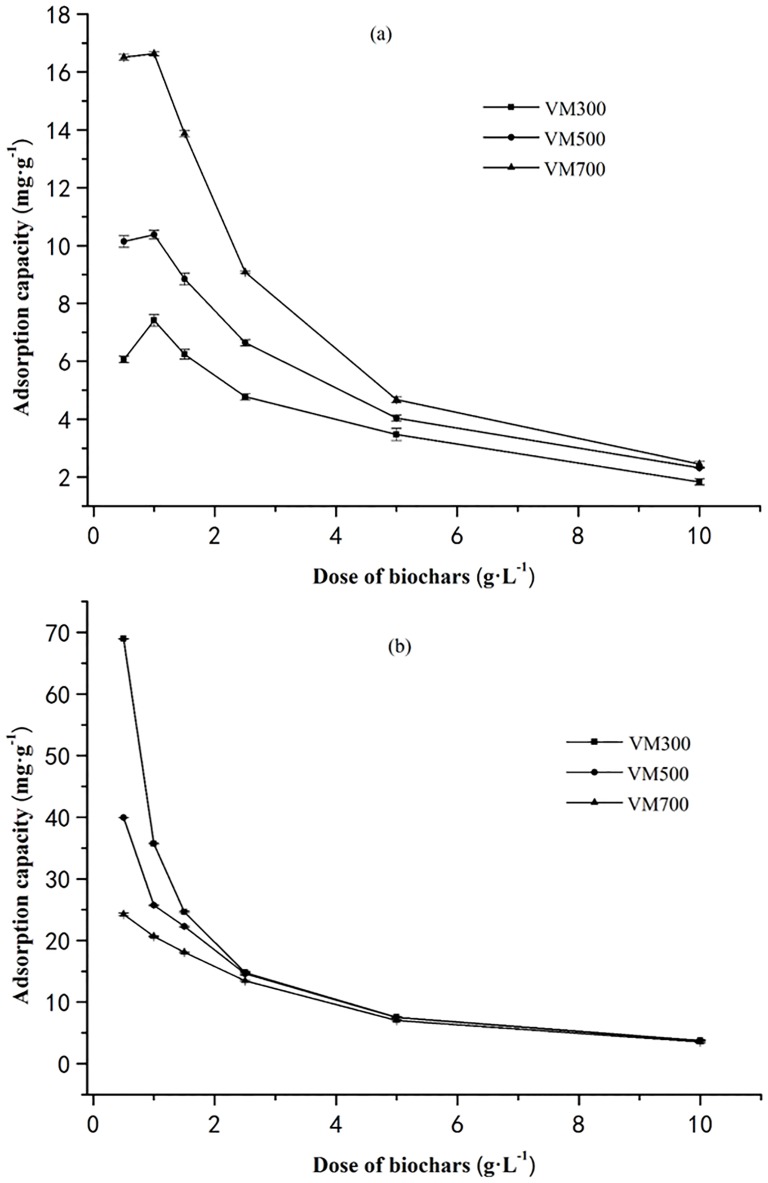
Effect of biochar dosages on the adsorption of CR (a) and MB (b).